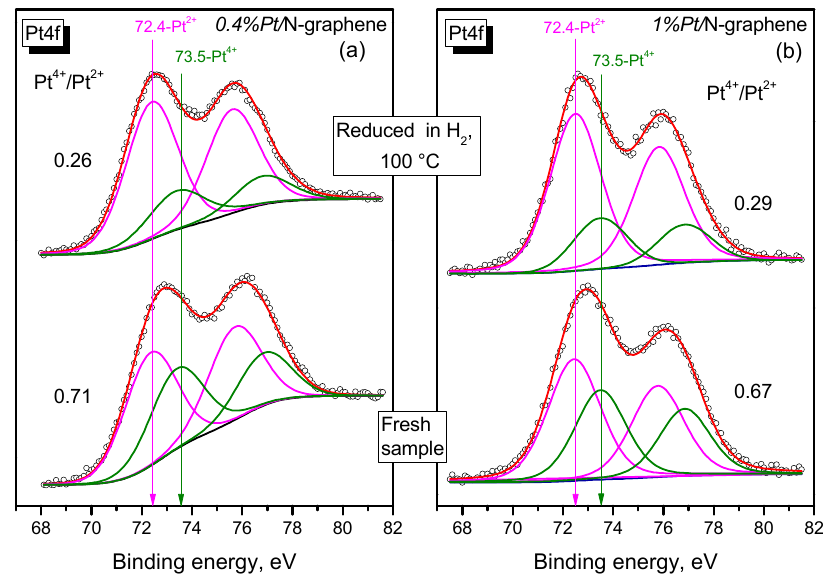
Figure 7. Pt4f spectra of 0.4% Pt/N-graphene ( a ) and 1.0% Pt/N-graphene ( b ) catalyst samples before and after reduction in the spectrometer